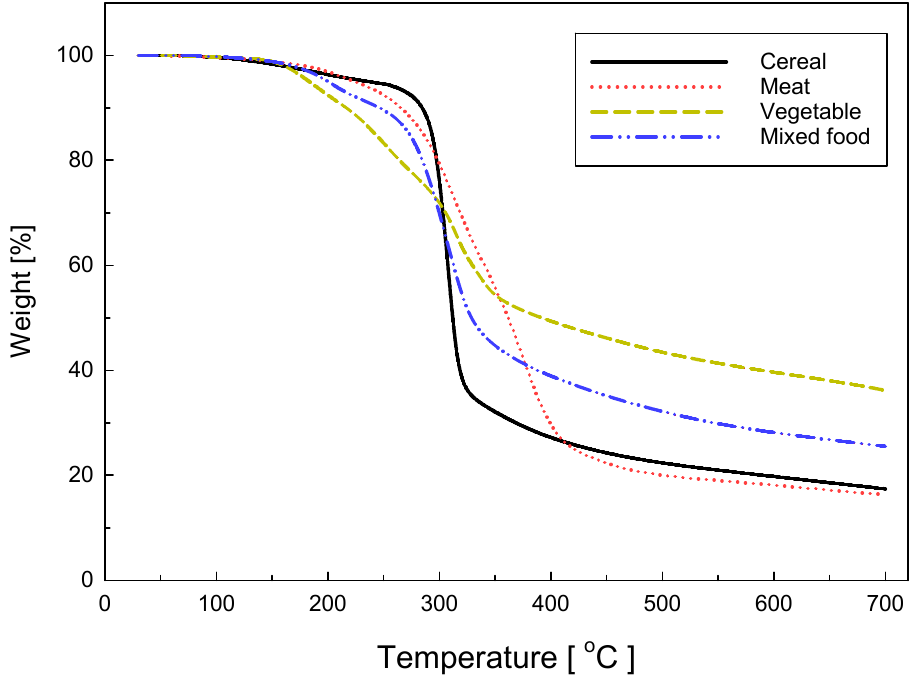
Figure 1. TGA curves of cereal, meat, vegetables, and mixed food pyrolysis at heating rates of 5 °C/min.